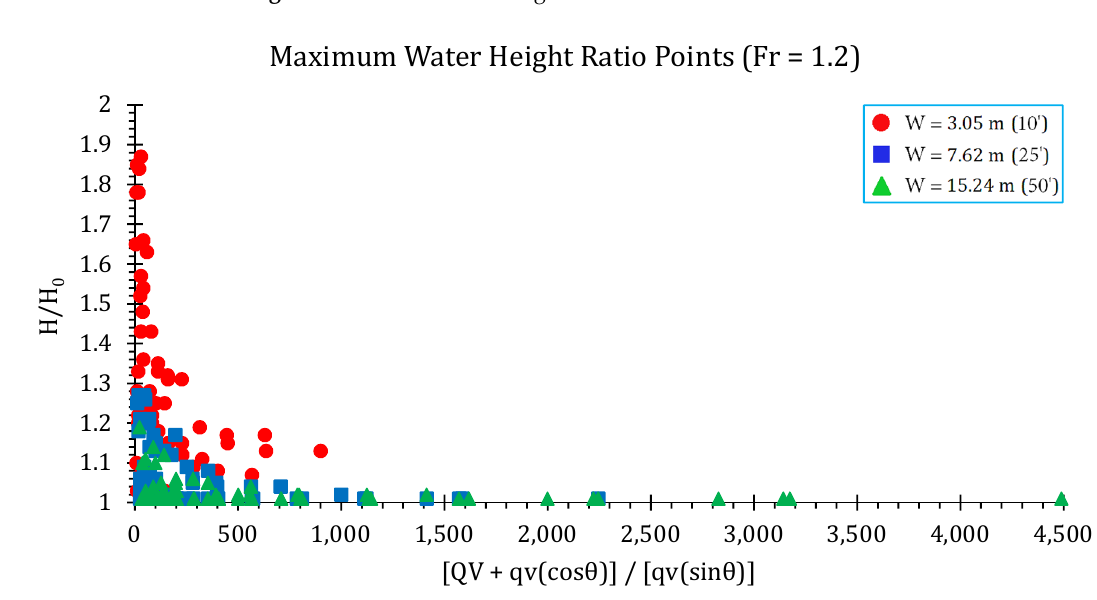
Figure 29. Conservative design curves for Fr = 2 in the channel.